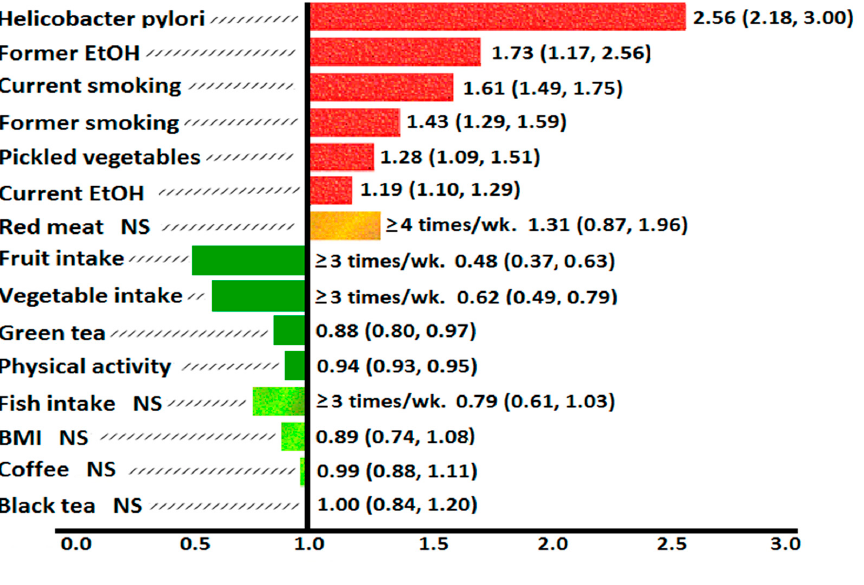
Figure 8. Odds ratios for risk factors and protective factors in gastric carcinogenesis (associations with 95% confidence intervals). Protective factors are shown in green (dark green, significant; light green, non-significant (NS)) and risk factors are shown in red (red, significant; orange, non significant). BMI: body mass index, EtOH: alcohol. Adapted from Poorolajal et al. [164].